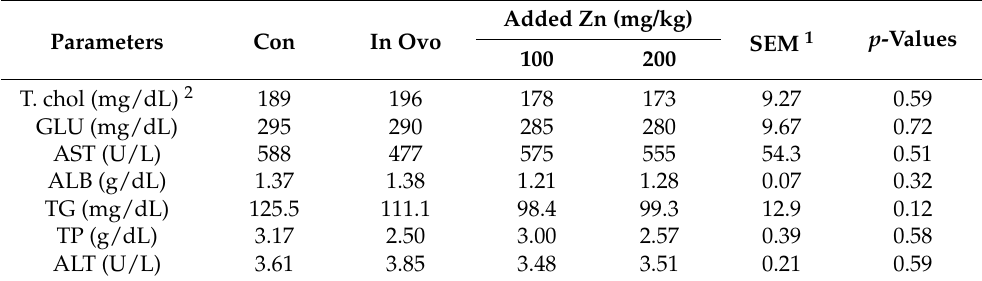
Table 3. Effect of in ovo injected and supplemental Zn on blood biochemistry characteristics in broilers at 35 days of